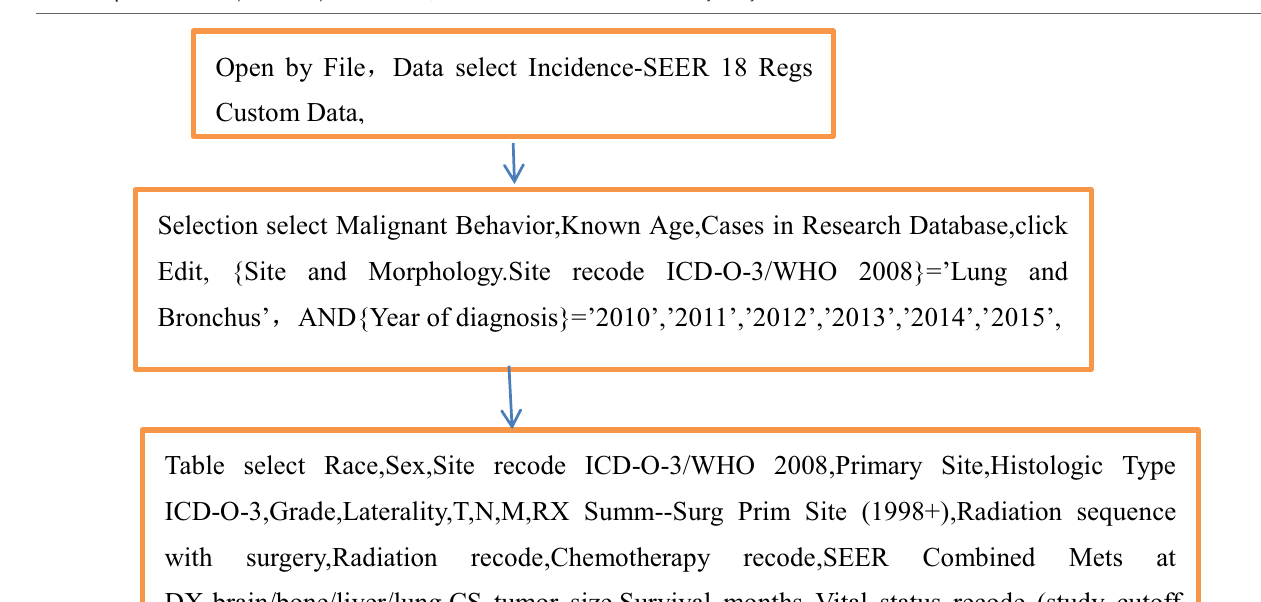
TABLE 1 | SEER data acquisition steps. A total of 2,072 cases were included in the study analysis.